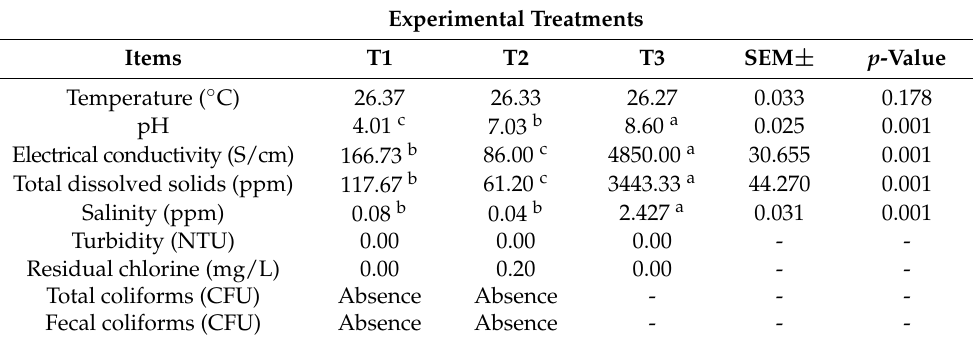
Table 2. Effect of acetic acid and sodium bicarbonate supplemented to drinking water on its physical, chemical and microbiological